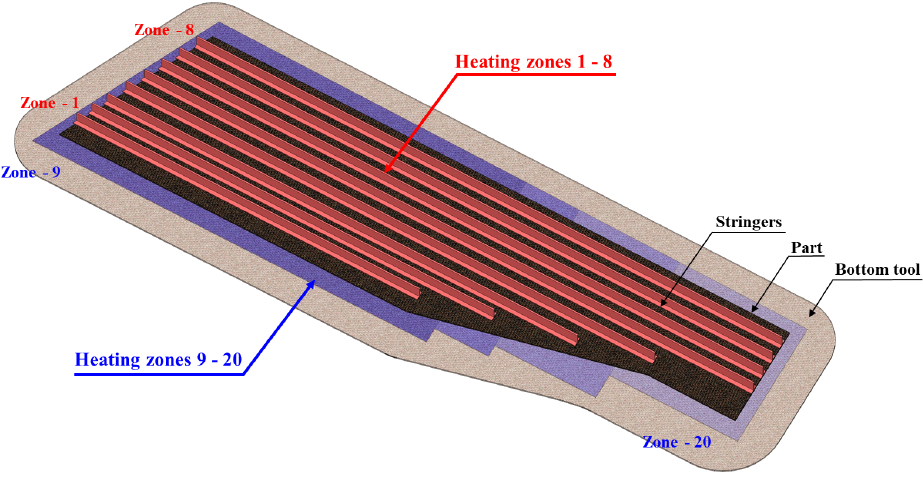
Figure 4: An illustration of the self-heating zones.